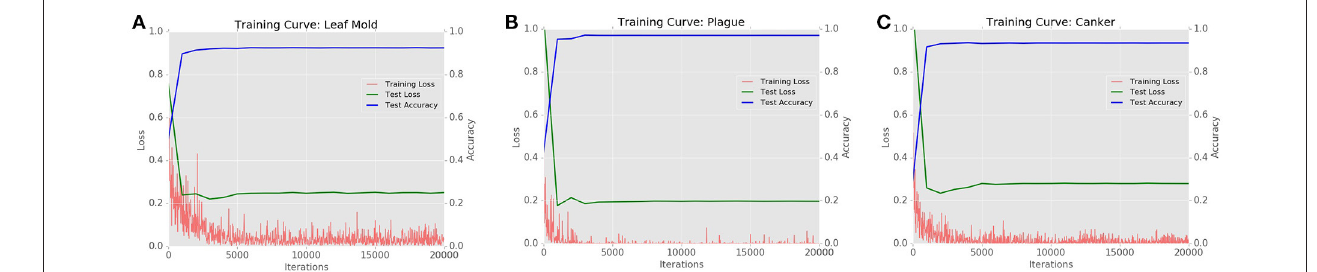
FIGURE 15 | Training curves generated by the CNN filter bank for the most challenging classes of the system (A) Leaf mold with AP: 92%, (B) Plague with AP: 97%, (C) Canker with AP: 93%.